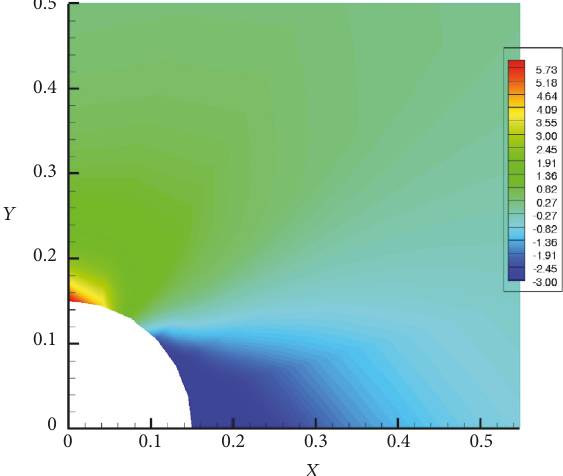
Figure 14: 𝑌 -component of net shear stresses at 𝑡 = 30 s in poroelastic medium with 𝜎 𝐻 = 16.8 MPa and 𝜎 ℎ = 14 MPa, 𝑃 𝑟 = 11MPa, 𝑃 𝑤 = 9.7 MPa, 𝑘 𝑥 = 0.01md, 𝑘 𝑦 = 0.01md, and 𝑇 𝑚 = 330